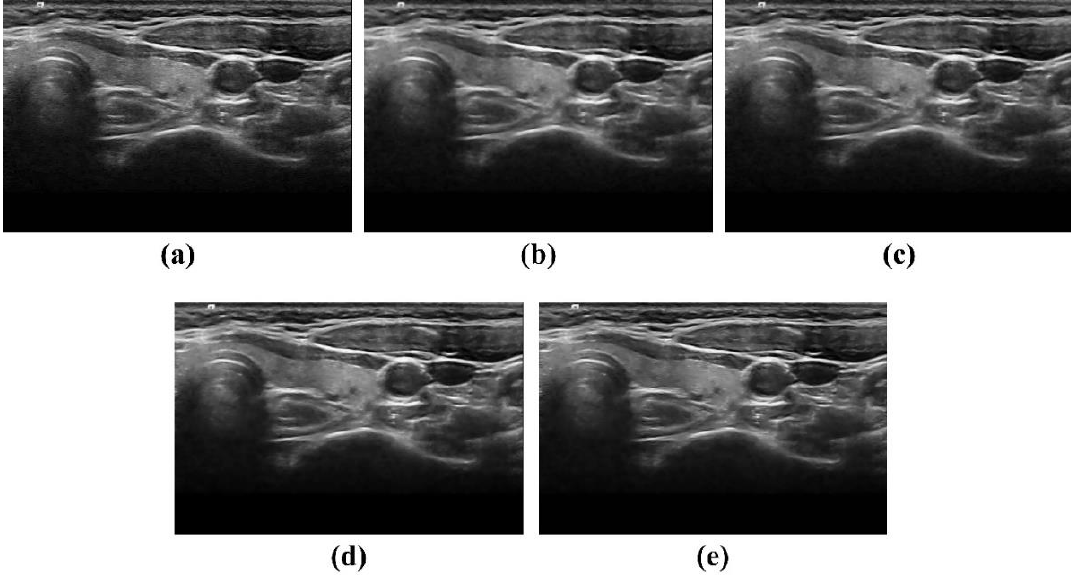
Figure 6. Acquired human thyroid ultrasound images captured using ( a ) noisy, ( b ) median filter, ( c ) Wiener filter, ( d ) PGPD, and ( e ) proposed non-local means noise-reduction algorithm.